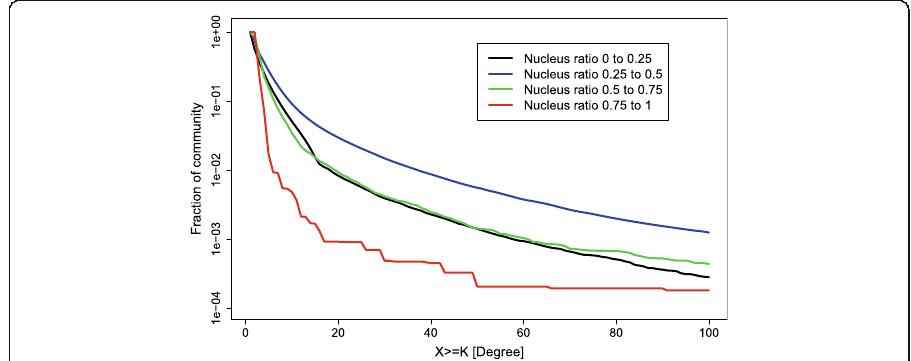
Fig. 10 The fraction of actors in a community with a given degree K or above (X axis), for varying ranges of nucleus-to-periphery ratios (see